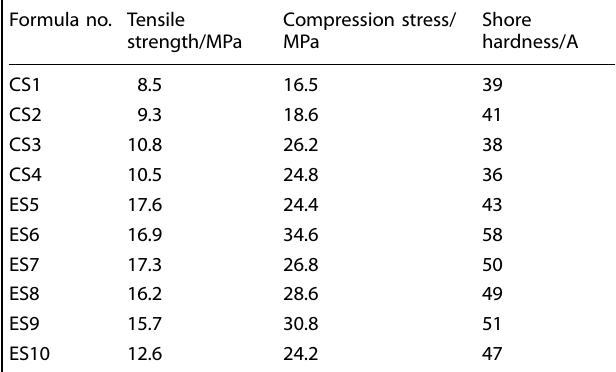
Table 1. Effect of fl ame-retardant loading on physico-mechanical properties of polyurea.